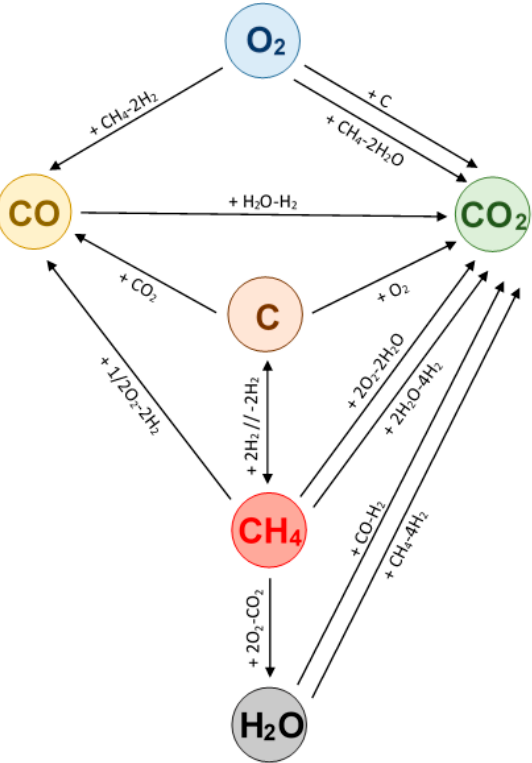
Figure 7. Scheme of the reactions running during the ATR process on Ni catalyst [113,114].